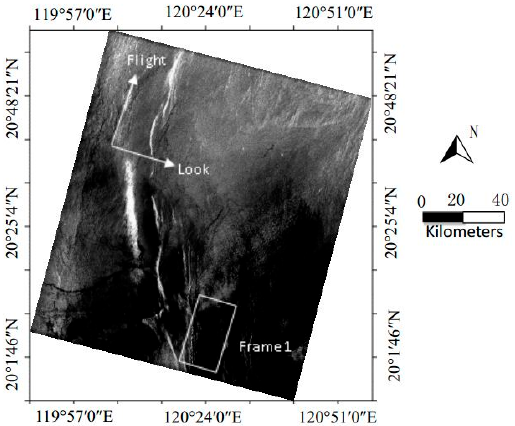
Figure 3. ERS-2 (European remote sensing satellite (ERS) was the European Space Agency's first Earth-observing satellite) ocean SAR image of South China Sea collected on 30 April 2005, at 02:28 UTC. Frame 1 is a subimage for the comparison between conventional SAR image and the corresponding estimated NRCS image.